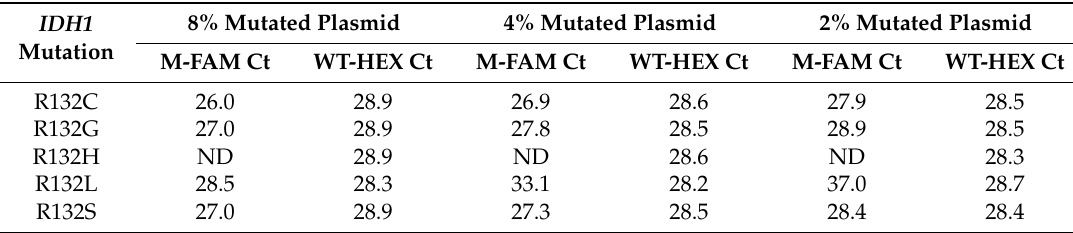
Table 2. Mean Ct obtained with different percentages of different IDH1 R132x mutations inserted in plasmid and IDH1 WT DNA.